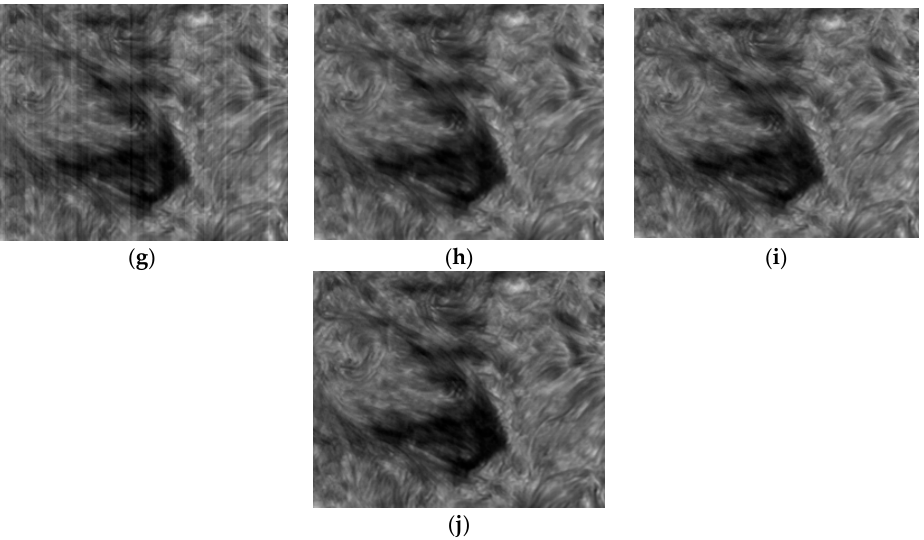
Figure 9. The results of various methods for removing stripes in the solar active area. ( a ) Global image with noise; ( b ) Original image of framed area; ( c ) Noise image of framed area; ( d ) WAFT; ( e ) Anisotropic total variation (UTV); ( f ) VSNR; ( g ) ASSTV; ( h ) SILR; ( i ) ℓ (cid:2868) sparse; ( j ) LRSUTV.